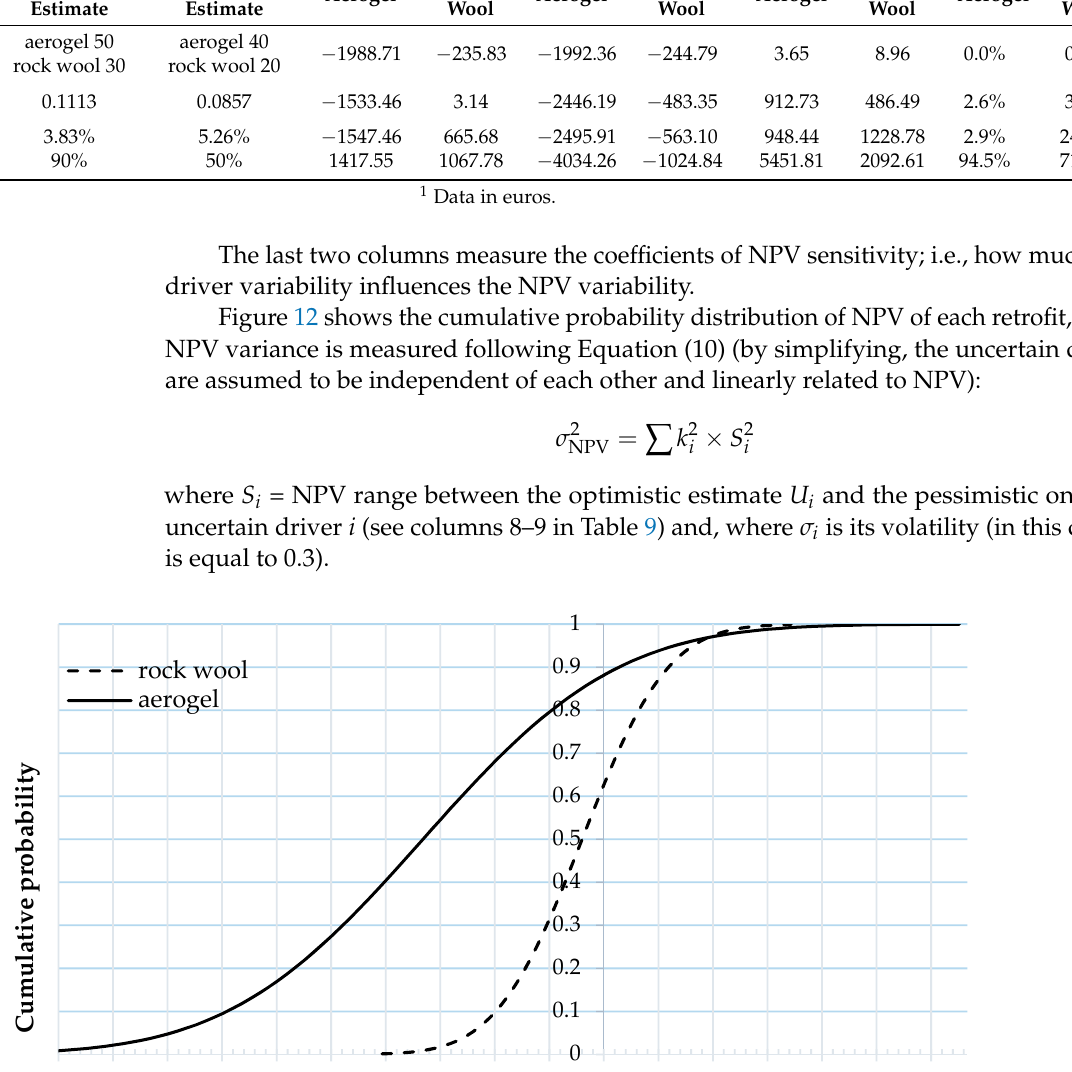
Table 10. Sensitivity Analysis of the NPV.